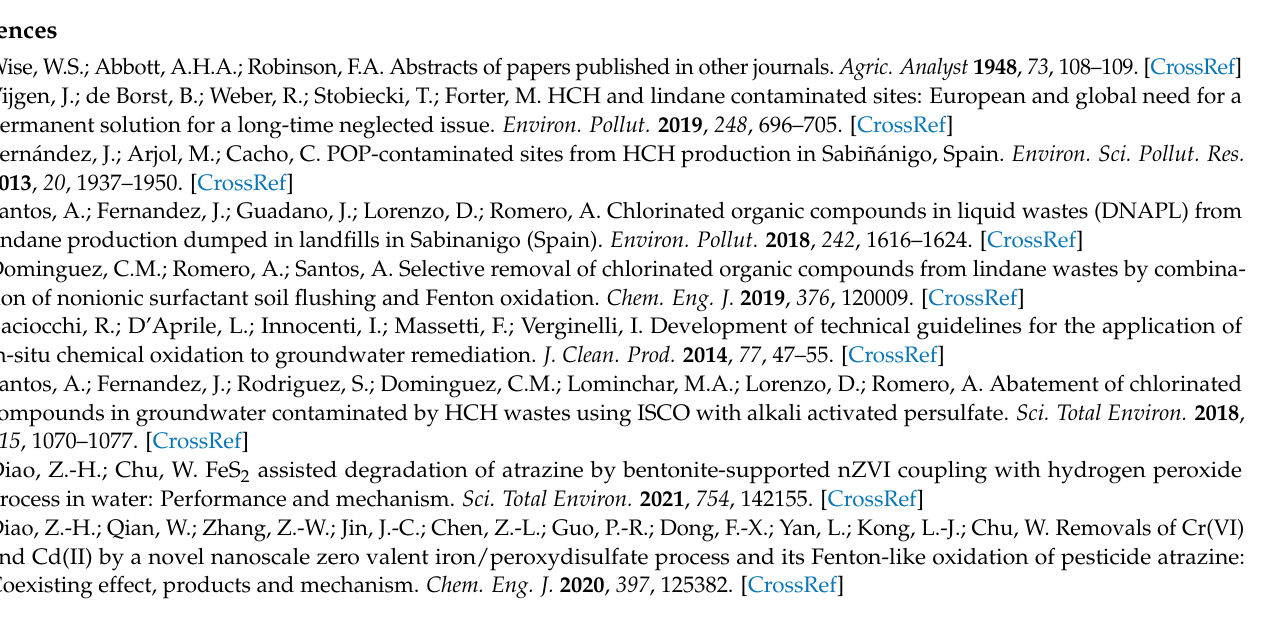
Table S2 Composition of the 8 gathered Pvs flushed from columns T1, T2 and T3 96 h after the last Pv was